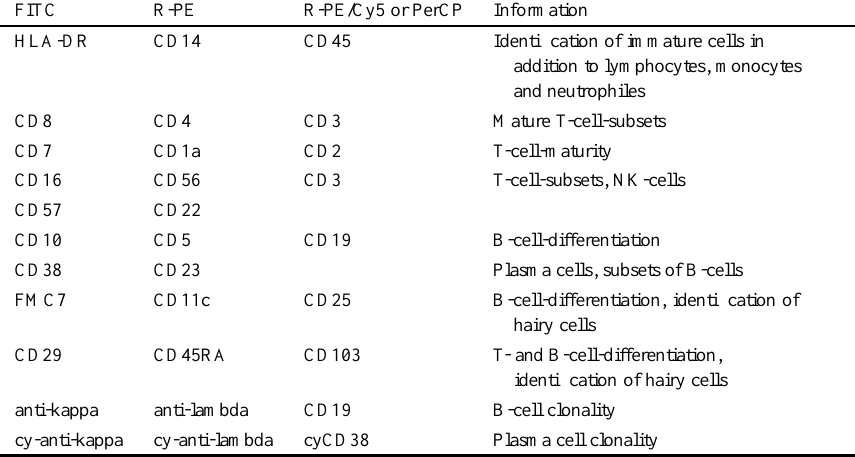
Antibody combinations used for the characterization of lymphocyte populations, and selected according to antigen coexpression patterns during normal maturation of cells. PE-conjugated antibodies were mainly se- lected for antigens of low expression